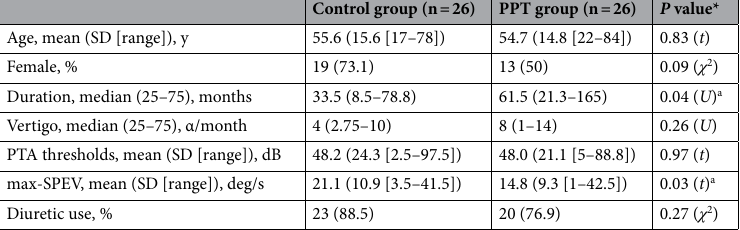
Table 1. Baseline characteristics of the study participants by treatment group. PPT positive pressure therapy, SD standard deviation, PTA pure-tone audiometry, max-SPEV maximum slow phase velocity. *Two- independent samples t test, χ 2 test, or Mann–Whitney U test after evaluating normality and equal variances. a Statistically significant